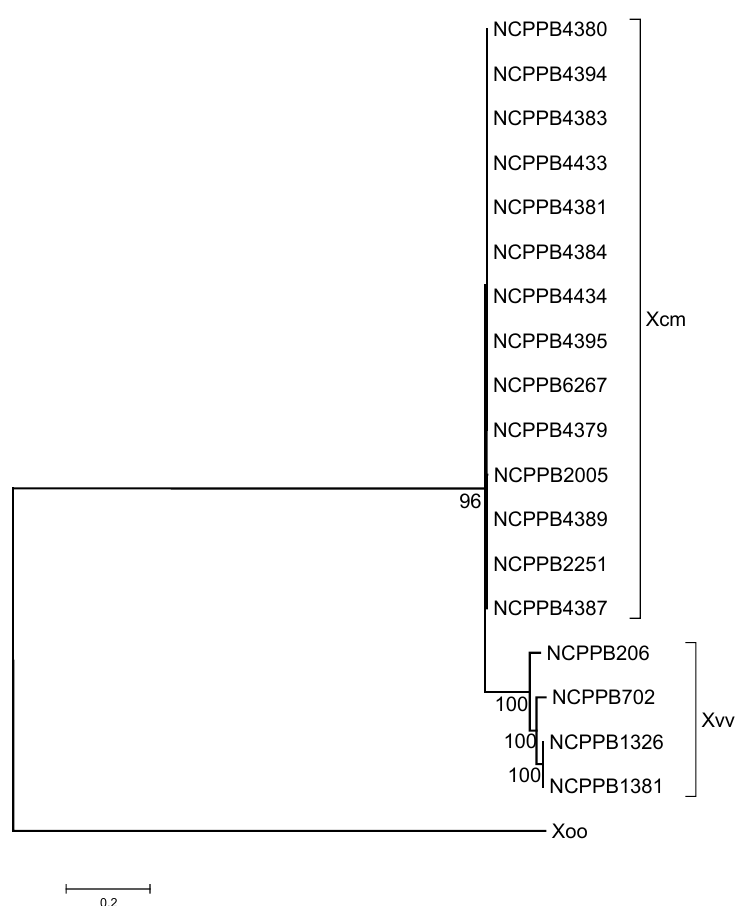
Figure 1. East African isolates of Xanthomonas campestris pv. musacearum ( Xcm ) from banana and enset comprise a monophletic clade closely related to Xanthomonas vasicola . A maximum likelihood phylogenetic tree was generated as described in the Experimental Section. The tree was rooted with X. oryzae pv. oryzae MAFF 311018 (“Xoo”) as the outgroup. The tree is based on 21,525 SNPs in 19 taxa. Branch lengths are drawn to scale and measured in the number of substitutions per site. Bootstrap values are given as percentages from 500 bootstrap